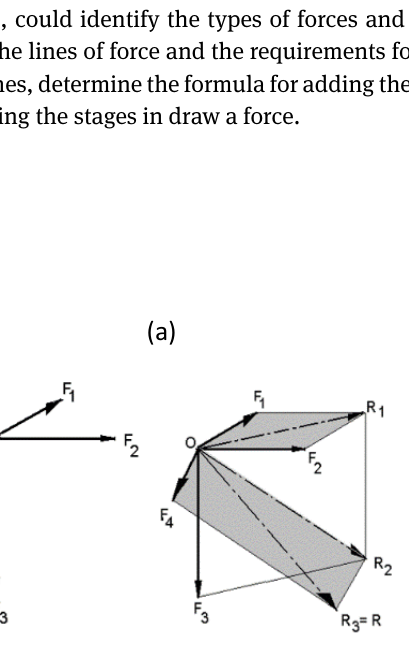
Figure 3: (a) Parallelogram method and (b) pole